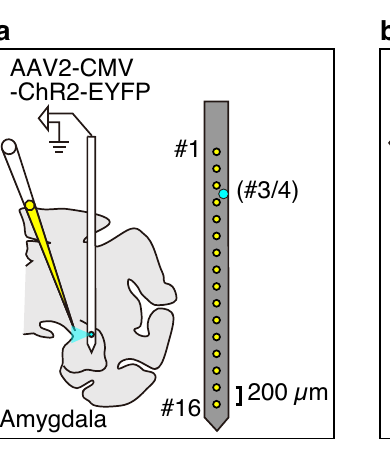
Fig. 2 | Optogenetic stimulation of amygdala-nigra pathway. a Injection of the viral vector (AAV2-CMV-ChR2-EYFP) into the amygdala and stimulation/recording of amygdala neurons via a 16-contact probe (yellow dots, 200 µ m interelectrode spacing) with a fi ber optic which is placed between contact 3 and 4 (cyan